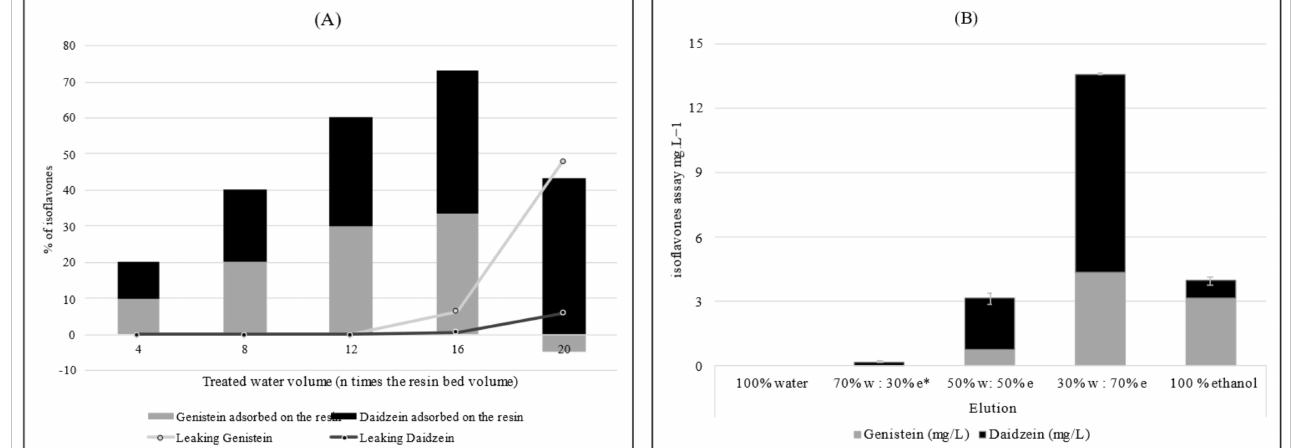
Figure 5. Isoflavones adsorption ( A ) and desorption ( B ) from Amberlite FPX 66 ® resin. The curves ( A ) represent progressive isoflavones leaking from the resin. * w and e refer to water and ethanol,